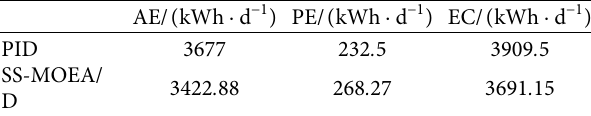
Table 5: Comparison of energy